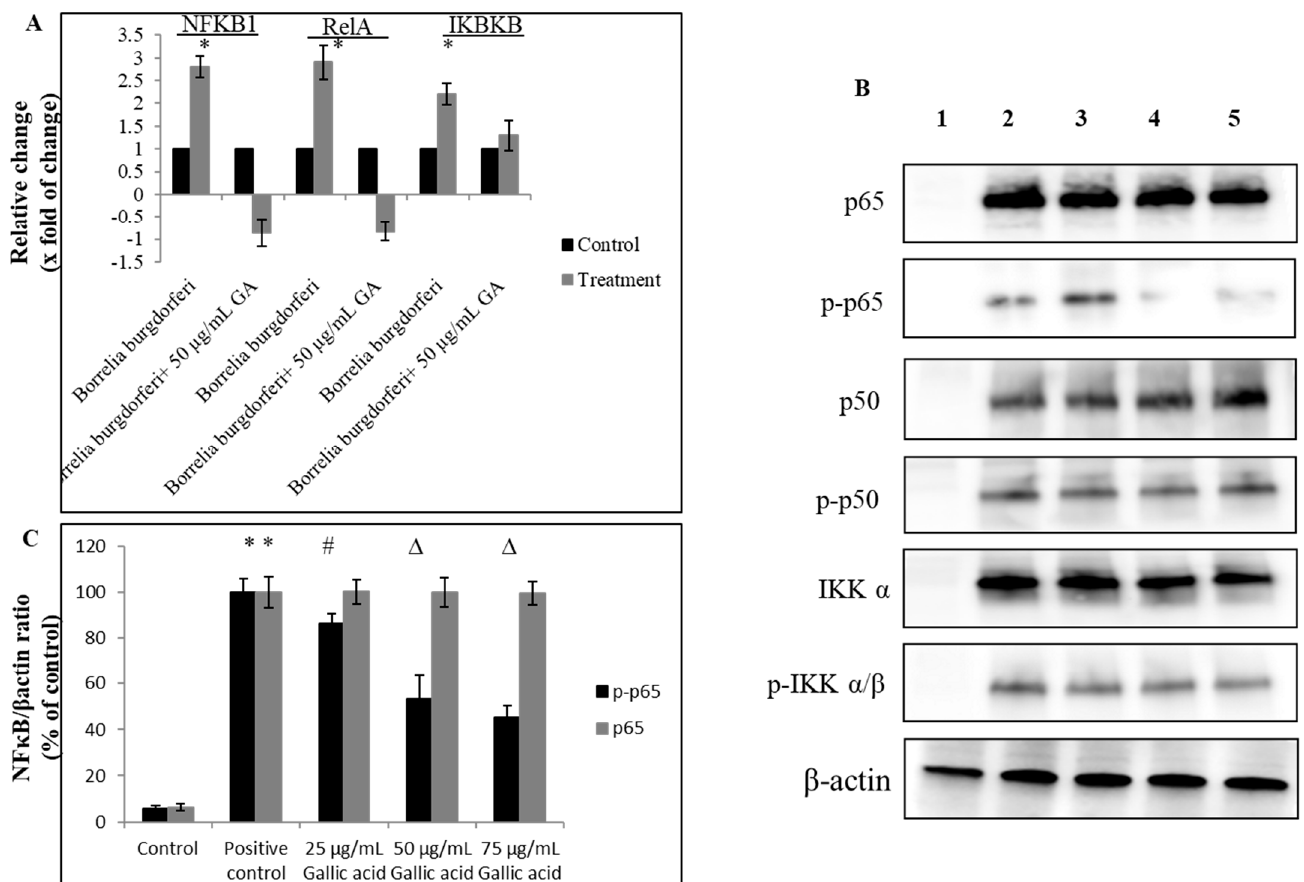
Figure 5. Effect of gallic acid on NF κ B canonical signaling pathway. Human CD14+ monocytes were treated with gallic acid (GA) upon B. burgdorferi 31 stimulation. Levels of proteins were assessed by RT-qPCR ( A ) and Western blot ( B ) after 12 h post-treatment. Densitometry of Western blot bands ( C ). 1—control cells not stimulated with B. burgdorferi ; 2—control cells stimulated with B. burgdorferi at cells:bacteria 1:5 ratio; 3—cells stimulated with B. burgdorferi at cells:bacteria 1:5 and treated with gallic acid at 25 μ g/mL; 4—cells stimulated with B. burgdorferi at cells:bacteria 1:5 and treated with gallic acid at 50 μ g/mL; 5—cells stimulated with B. burgdorferi at cells:bacteria 1:5 and treated with gallic acid at 75 μ g/mL; # p ≤ 0.05, ∆ p ≤ 0.01, * p ≤ 0.001; control—DMSO only (0.035%).